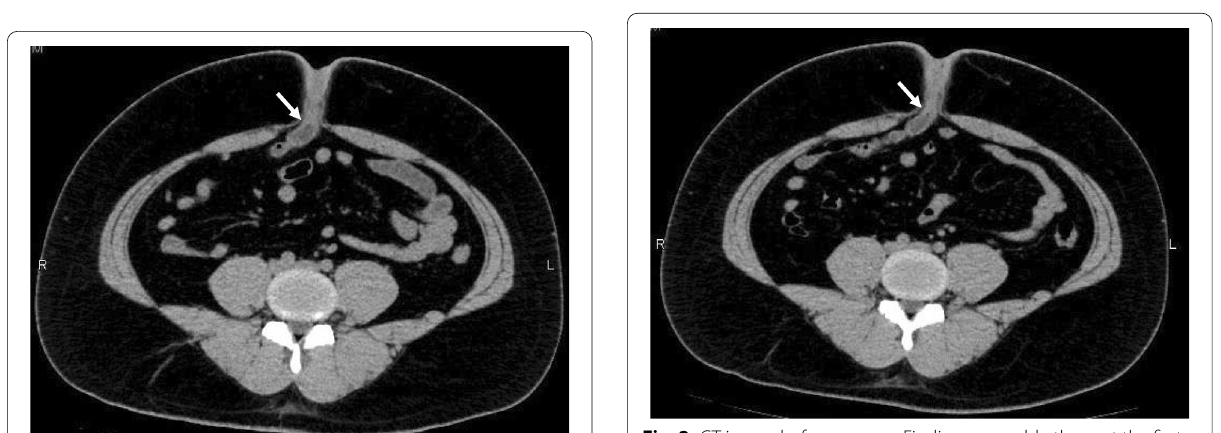
Fig. 2 CT image before surgery. Findings resemble those at the first visit, showing a luminal structure with liquid retention just below the umbilicus